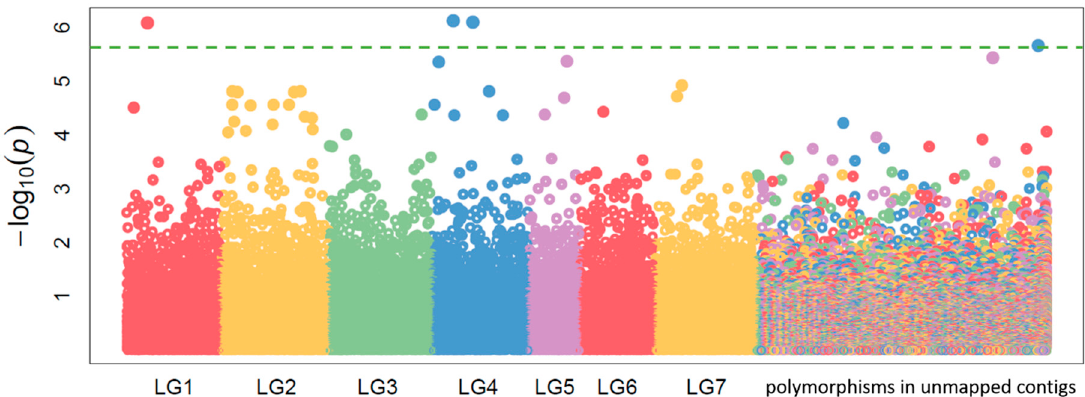
Figure 8. Manhattan plot of genome-wide association of allele frequency and 15 N nitrogen fixation phenotypes using the FarmCPU algorithm. The di ff erent colors (LG1–LG7) indicate di ff erent linkage groups [35]. The segment to the far right shows the polymorphisms unmapped to the linkage groups. The green line indicates the false discovery rate-adjusted p -value of 0.05 using the Benjamini–Hochberg correction [46].